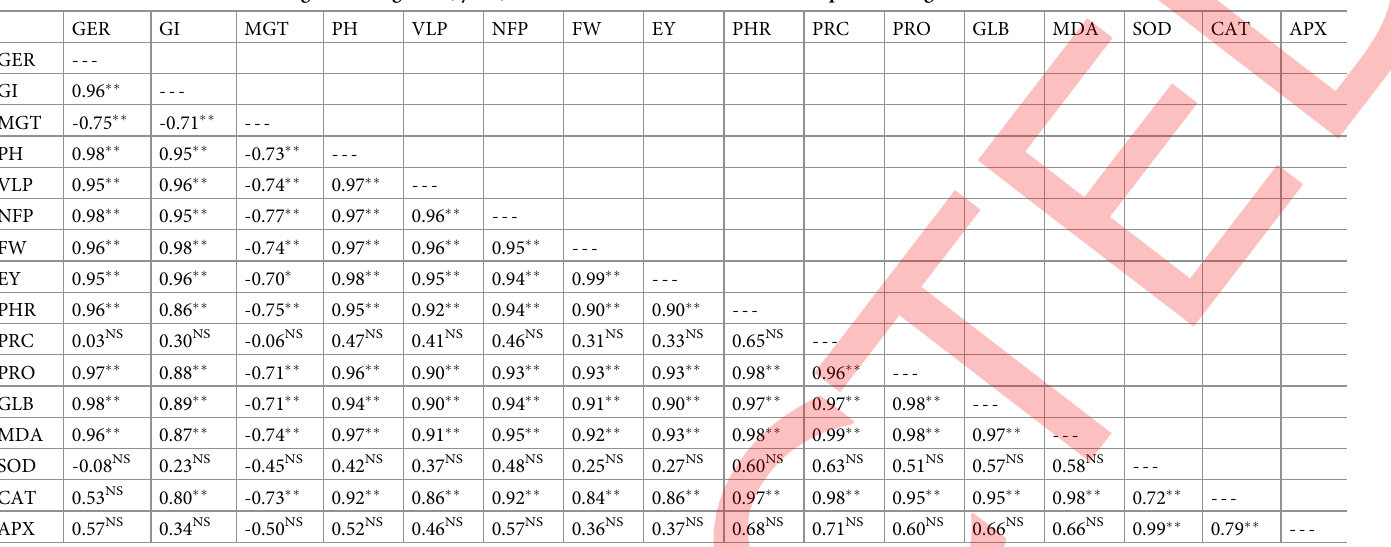
Here, Germination = GER; Germination index = GI; Mean germination time (Days) = MGT; Plant height = PH; Vines length per plant = VLP; Number of fruits per plant = NFP; Fruit weight per plant = FW; Economic yield = EY; Photosynthesis rate = PHR; Protein contents = PRC; Proline content = PRO; Glycine betaine =